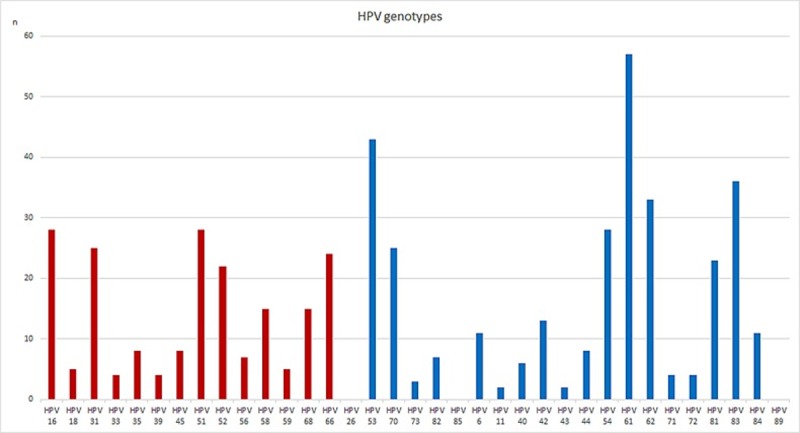
Distribution of all detected genotypes, lrHPV and hrHPV, in both the consent and non-consent group.Shown in the blue square are the genotypes included among the 14 most clinically used genotypes.